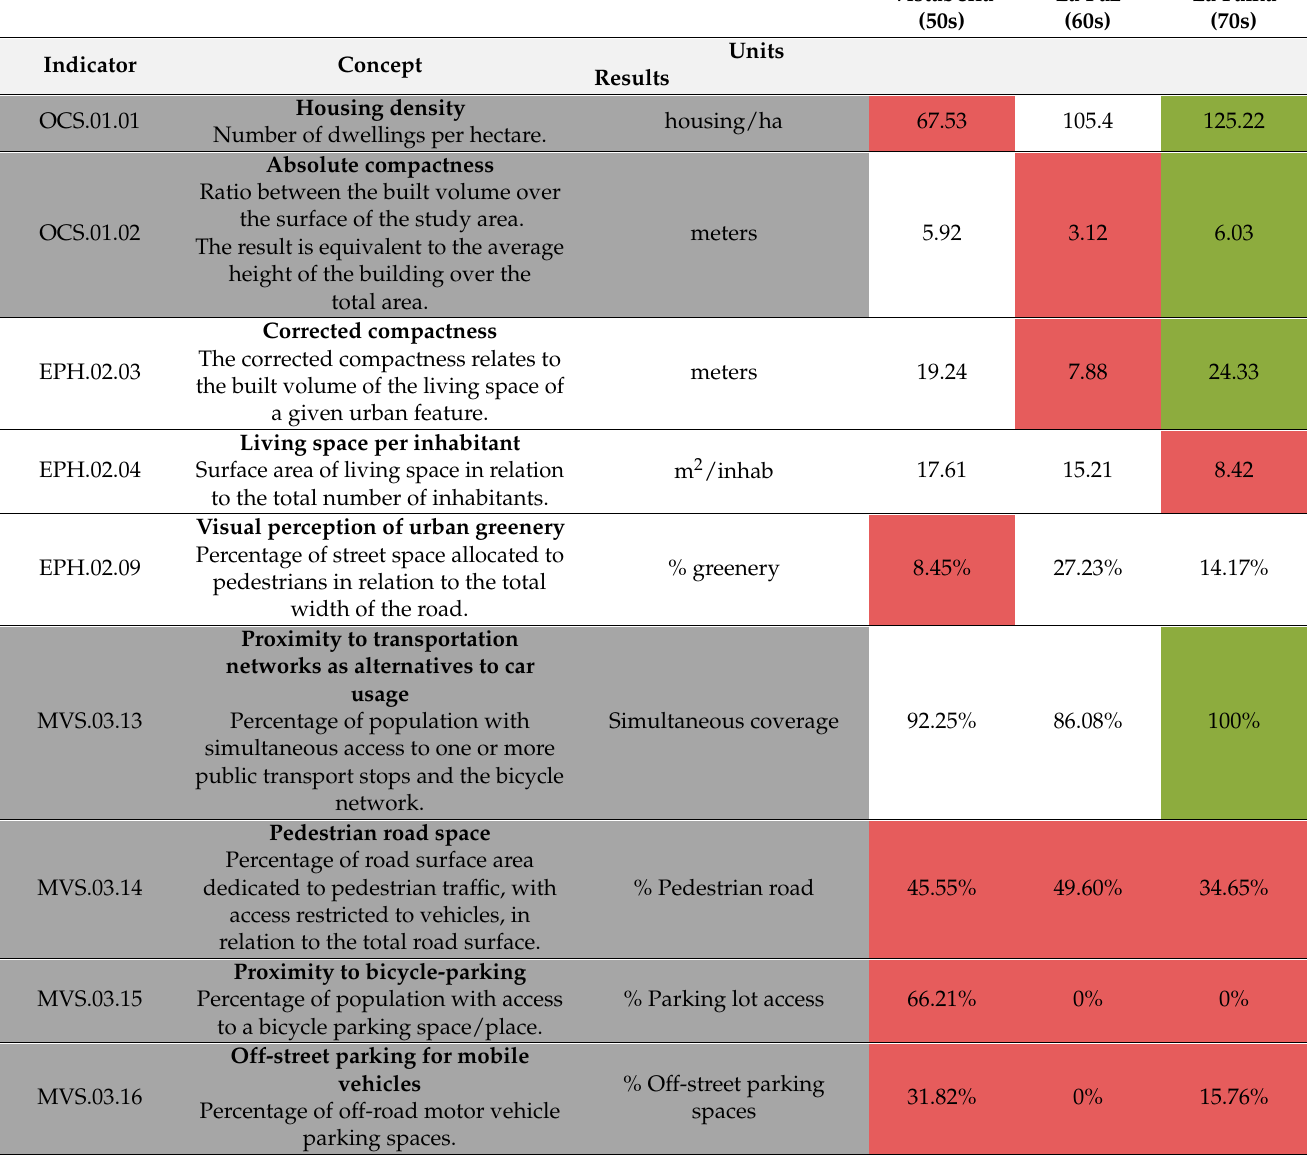
Table 2. Urban Ecology Agency